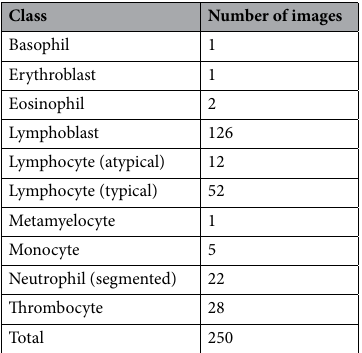
Table 1. The re-annotated dataset. An expert cytologist classified single-cell images into ten different types of blood cells. These expert labels are used for the multiclass classification and available as Supplementary Table S1.